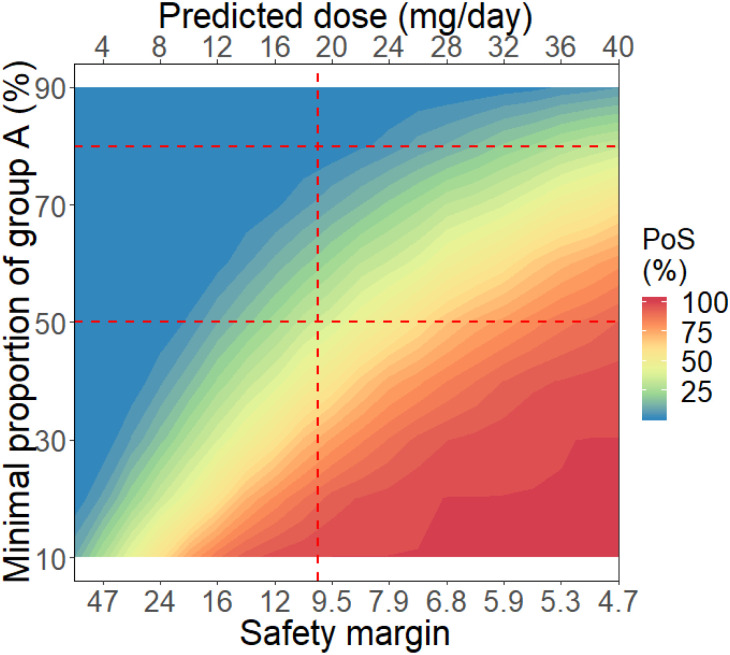
The Probability of Pharmacological Success (PoPS) (%) for having a minimal proportion of patients in Group A (conditioned on <5% patients in Group C+D) as a function of exposure safety margin, or the predicted dose.The horizontal lines represent the requirement of at least 50% and 80% patients in Group A. The vertical line marks 19 mg/day dose that’s predicted to produce a 10-fold exposure safety margin.